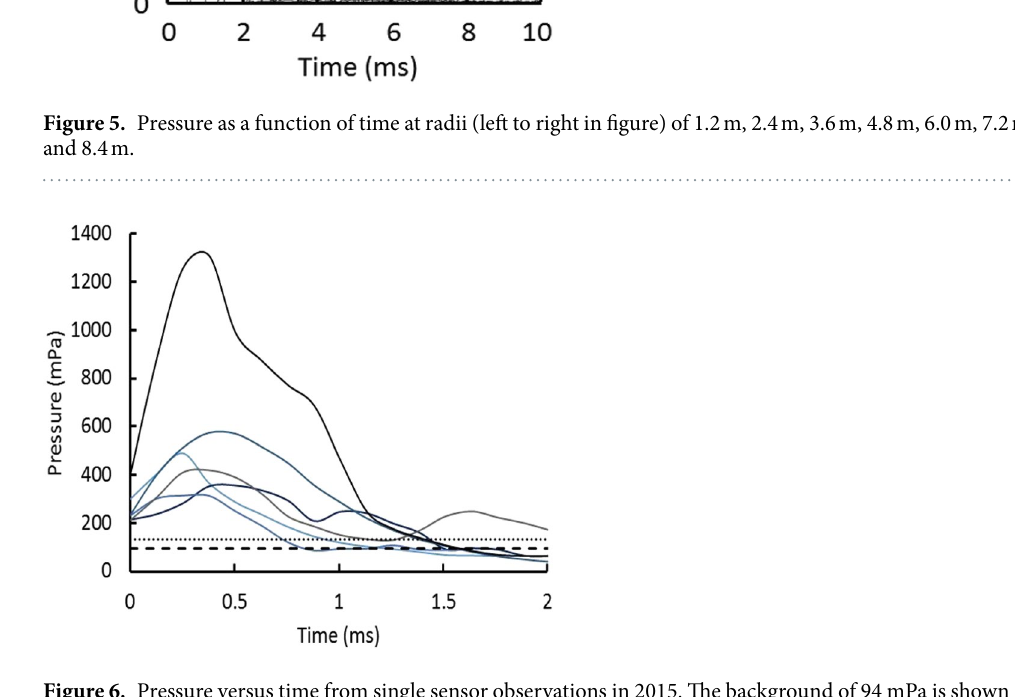
Figure 6. Pressure versus time from single sensor observations in 2015. The background of 94 mPa is shown as dashed line. The background plus 10 of the 4 mPa standard deviations in the background (i.e. 134 mPa) is shown as the dotted line for comparison. The background of 94 mPa pressure is the mean amplitude of the fluctuating pressure in the 500 Hz to 30 KHz band of the hydrophone, taken over 10,000 samples at 1 million samples per second. The 4 mPa is the standard deviation of those 10,000